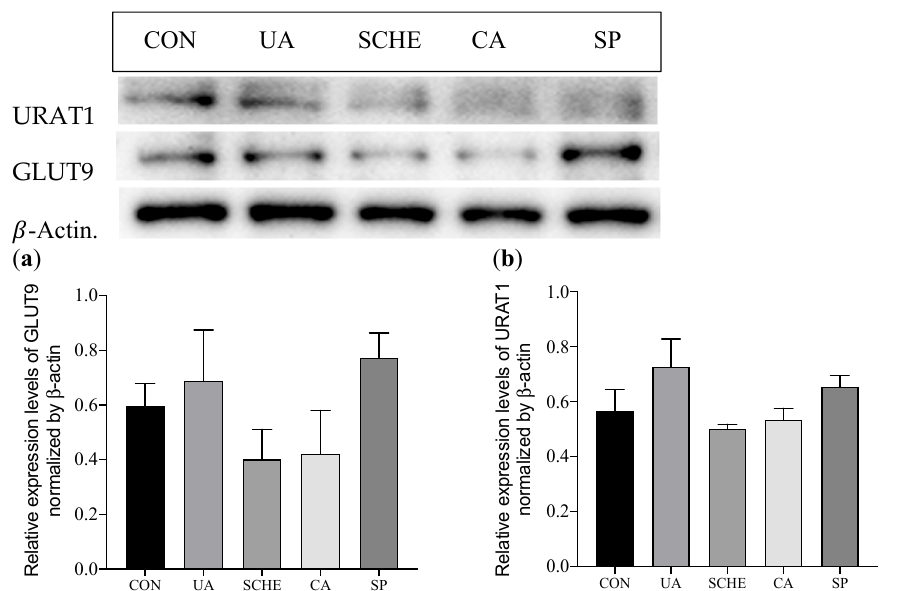
Figure 4. Expression levels of GLUT9 ( a ) and URAT1 ( b ), detected in UA-induced HEK293T cells. Bar graphs represent the relative expression levels and were calculated by Image J, as well as the error bars that indicate the mean ± SD.